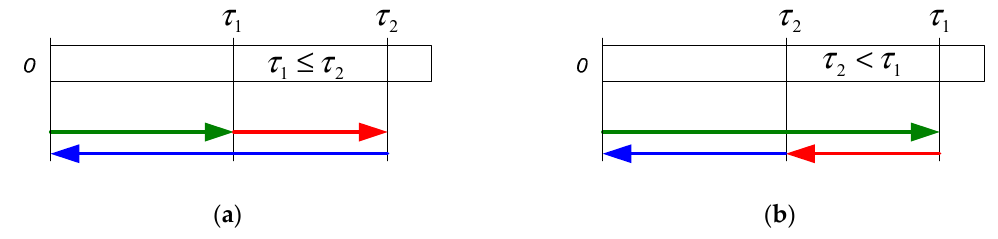
Figure 6. Dual command scheme in a one-dimensional service zone. ( a ) τ 1 ≤ τ 2 , ( b ) τ 1 > τ 2 .